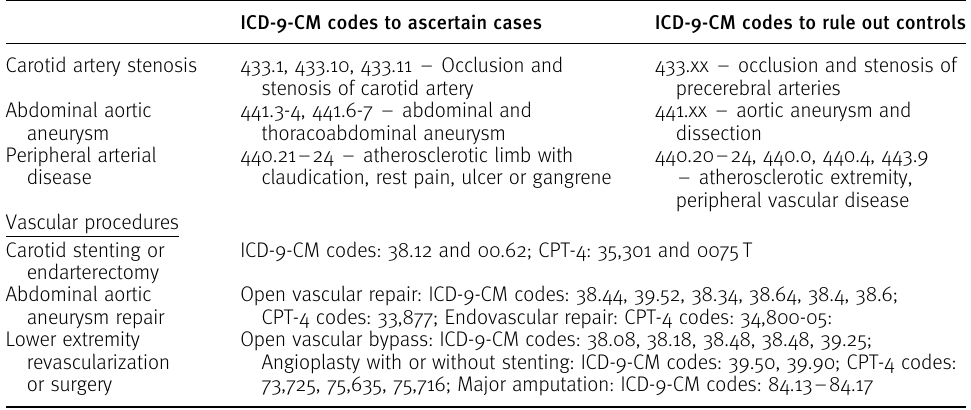
Table 2. Algorithms to ascertain atherosclerotic vascular disease cases and